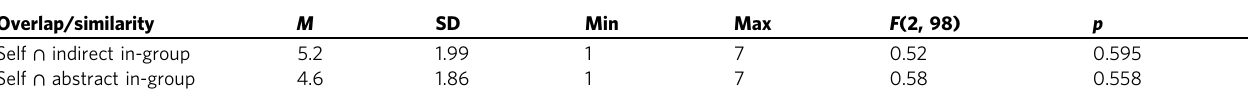
Table 2 Overlap/similarity on the Inclusion of Others in the Self Scale.